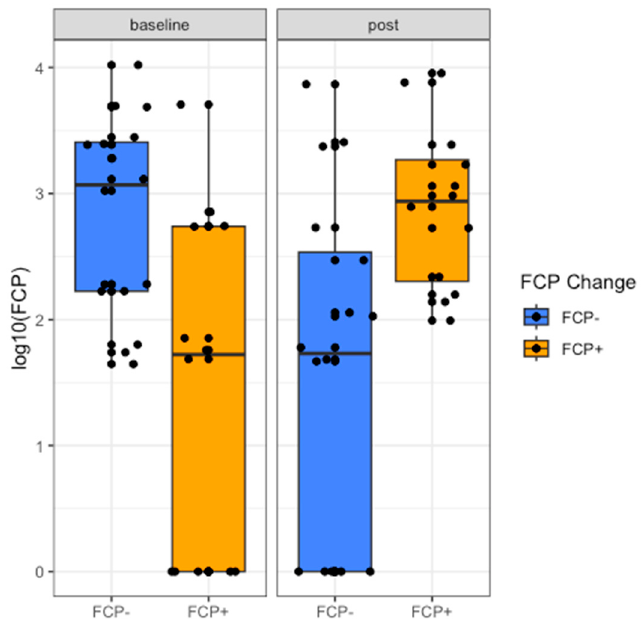
Figure 1. The identification of two distinct trajectories for fecal calprotectin. Participants whose fecal calprotectin increased at week 8 had significantly lower levels at baseline and significantly higher levels at week 8.